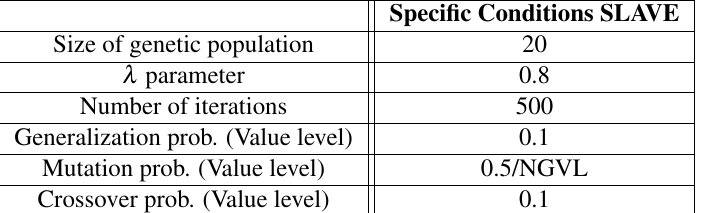
Table 2. Specific conditions for SLAVE. NGVL means the number of genes in the value